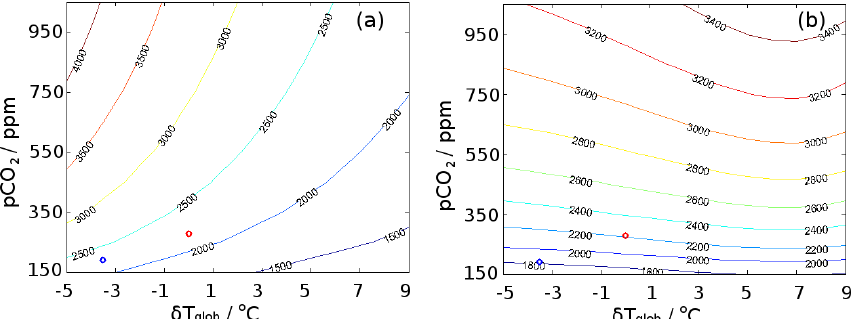
Figure 3. Steady-state land biomass (GtC) as a function of global mean temperature ( ◦ C) and p CO 2 (ppm) deviations from the calibrated PI value for (a) the old uniform biosphere scheme and (b) the new biosphere scheme with three vegetation zones. The red circles denote PI and the blue circles LGM conditions.